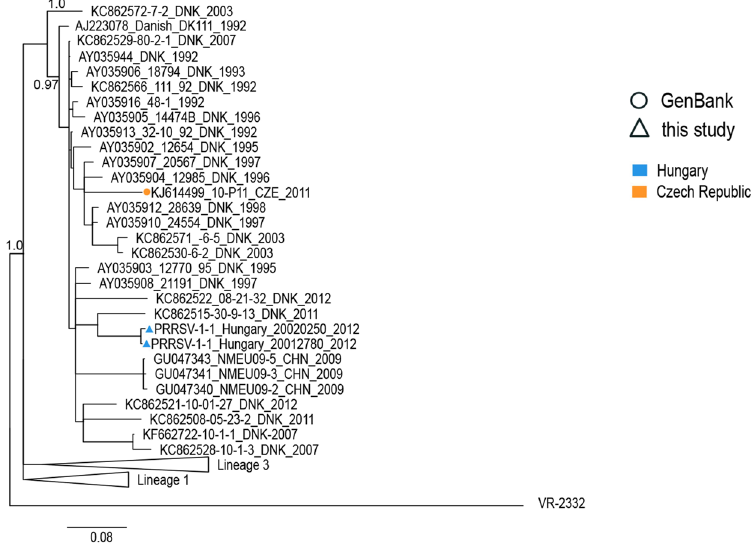
Figure 4. Phylogenetic tree of lineage 2 based on ORF5 sequences constructed in MrBayes 40 . PRRSV 2 prototype strain VR2332 (AY150564) was used as an outgroup. Posterior probability values supporting main nodes were shown. Geographical origin and year of isolation were indicated for each